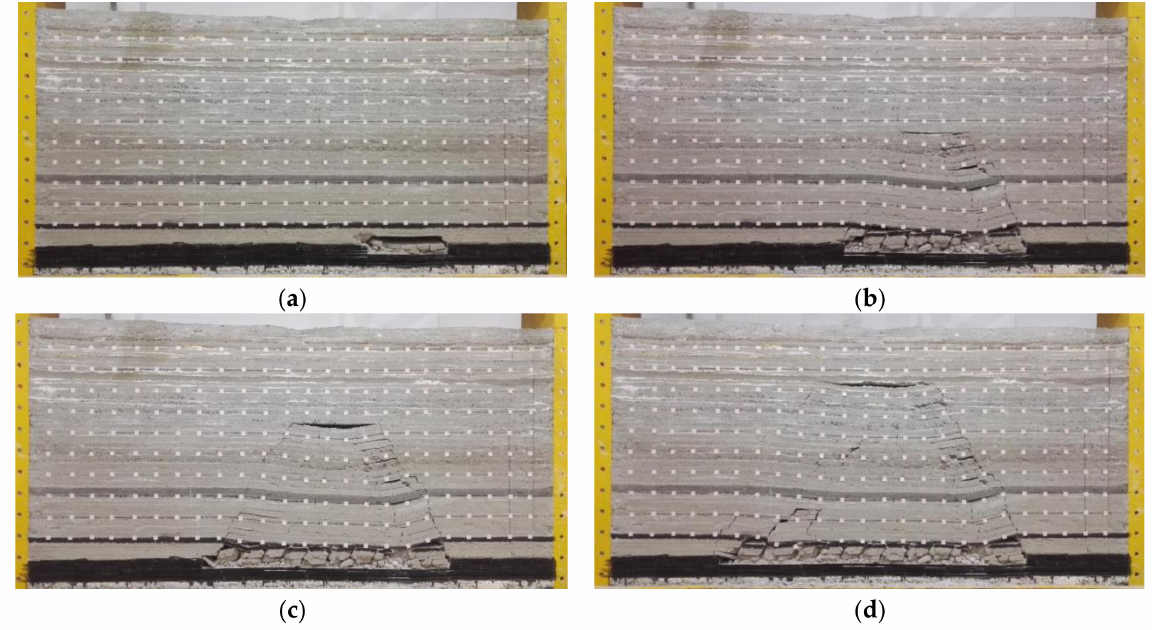
Figure 7. Overburden failure characteristics: physical analog model with the working face advancing at 96 m ( a ), 216 m ( b ), 288 m ( c ), and 360 m ( d